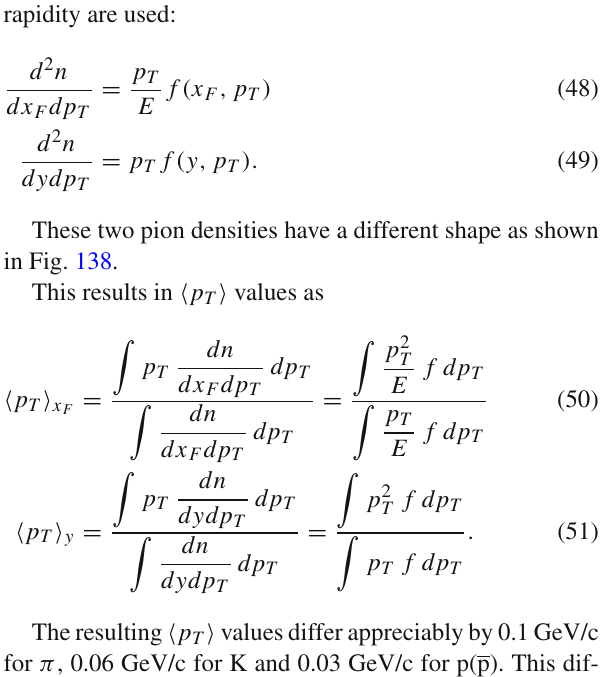
and (cid:4) p T (cid:5) y values are different F